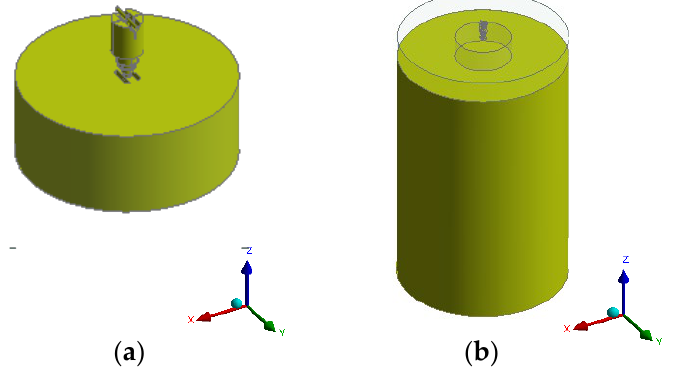
Figure 6. TD-ST type AIN model.